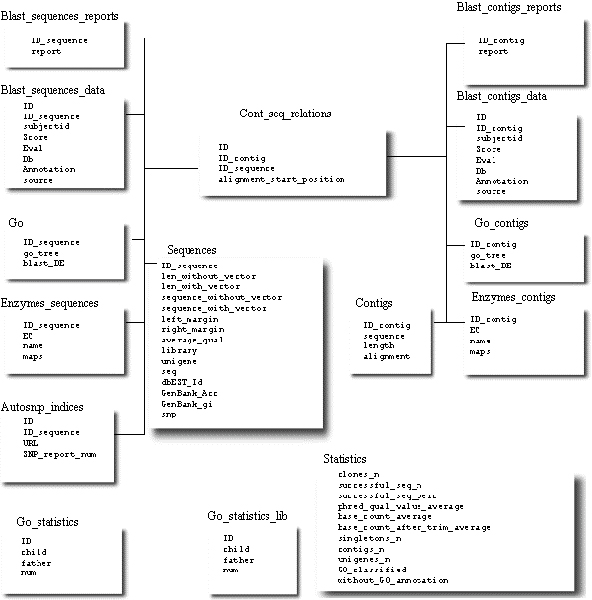
The ESTree db database structure. Main tables of the ESTree MySQL db. The database structure is subject to frequent changes, due to the implementation of the database features.